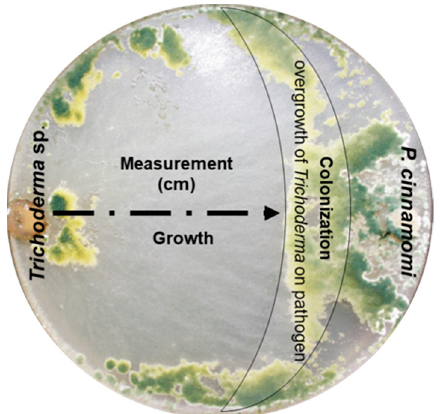
Figure 2. Aspect of Trichoderma strain colonization over the plant pathogen Phytophthora cinnamomi after 8 days.